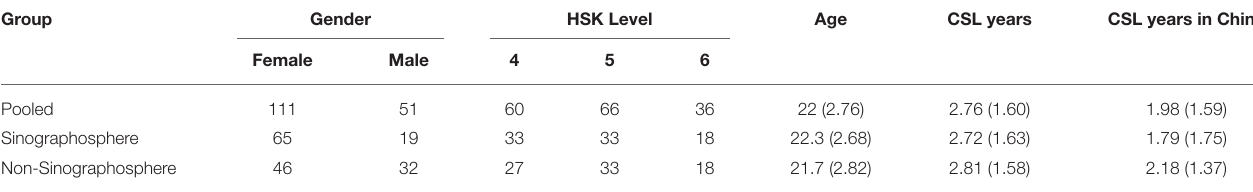
TABLE 2 | Demographic information of